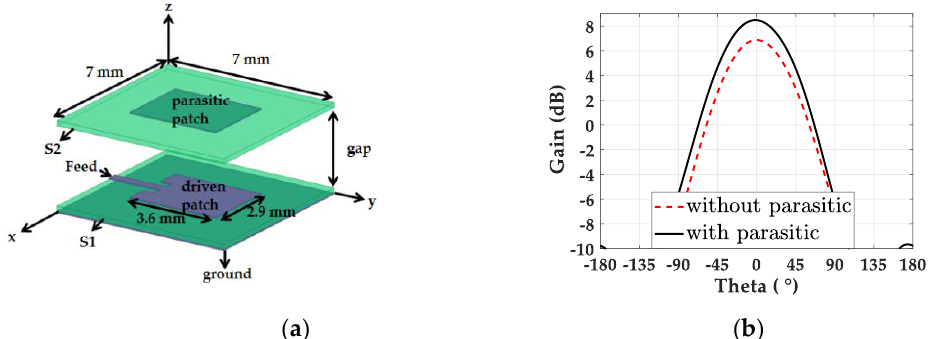
Figure 1. ( a ) Structure of the single patch with the parasitic element. ( b ) Gain of the patch with and without the parasitic patch in the x-z plane along theta ( θ ).